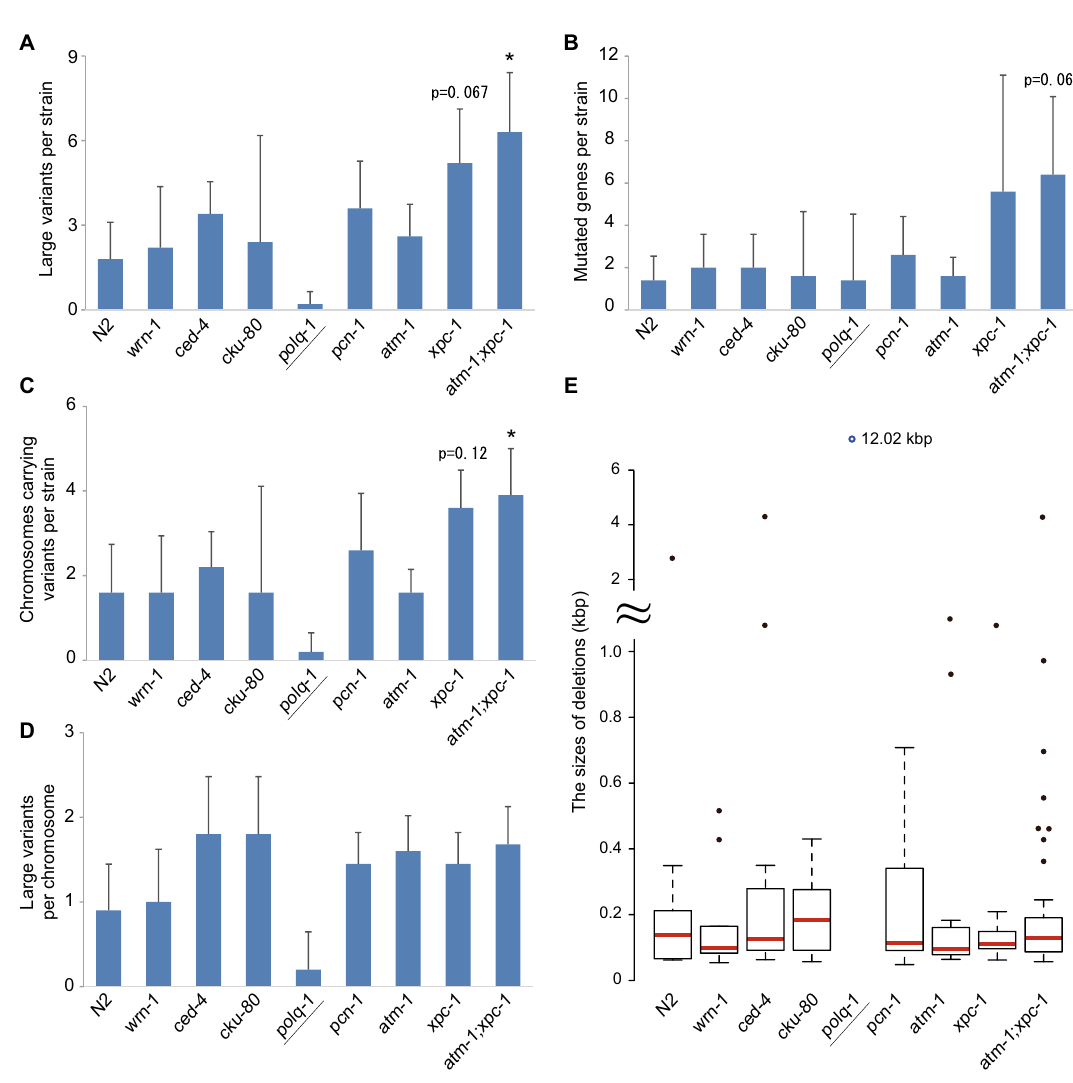
Figure 3. Whole genome sequencing of DDR mutants. The 5 or 10 independent lines of the TMP/UV treated N2 and DDR mutants were clonally propagated for 10 generations and the whole genome of the worms was sequenced using ionProton (Thermo Fisher Scientific). ( A ) The number of deletions larger than 50 bp for each strain is shown in a bar graph. Not only simple deletions but also complex deletions with insertions or inversions were counted. The polq-1 mutant shows heterozygous mutations, while the others are homozygous variants. The atm-1;xpc-1 mutant showed a significantly larger number of variants than wild-type by Steel’s test (p-value is 0.034, marked as asterisk). ( B ) The number of genes that were partially or completely deleted for each strain is shown in the bar graph. The atm-1;xpc-1 mutant showed not significant but the highest values (p-value is 0.068, Steel’s test). ( C ) The number of chromosomes carrying large variants per strain is shown in the bar graph. The atm-1;xpc-1 mutant showed a significantly larger value than wild-type by Steel’s test (p-value is 0.036, marked as asterisk). ( D ) The number of large variants per chromosome was shown in the bar graph. There was no significant difference between wild-type and DDR mutants by Steel’s test. ( A – D ) The error bars mean the SD. ( E ) The distribution of the deletion sizes (Supplementary Table S5). The upper panel shows larger than 1 kb and the lower panel shows less than 1 kb deletions. The variant derived from polq-1 mutant is shown as a labeled blue circle because the size of it was extremely outside the range of the other variants. The red lines and boxes indicate the median values and interquartile ranges, respectively. The whisker shows a range of 1.5 × interquartile range. There was no difference among the strains by Kruskal–Wallis rank sum test (p-value is 0.63). All statistical analyses were performed using R software 56 with mutations in xpc-1 can introduce large varaints with higher efficiency than the wild type. In constructing a mutant library, the higher the expected cumulative number of mutations obtained from each P0 worm, the more efficiently mutant strains can be isolated. The survival rate of F1 larvae was higher in the atm-1;xpc-1 double mutant than in the xpc-1 single mutant (Table 1), suggesting that TMP/UV treatment of atm-1;xpc-1 is expected to be more efficient.